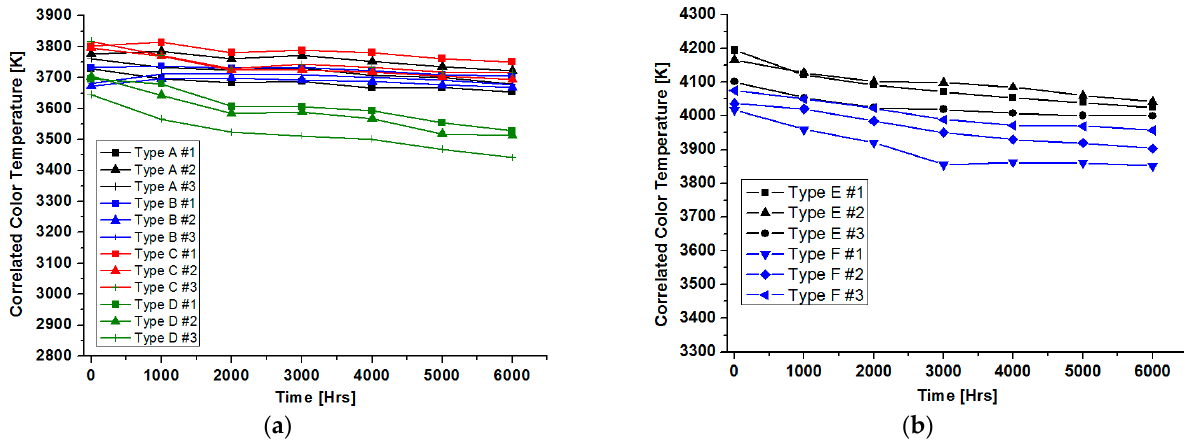
Figure 3. Characteristics of maintained correlated color temperature (CCT) of OLED products. ( a ) Maintained CCT of OLED panels. ( b ) Maintained CCT of OLED luminaires.